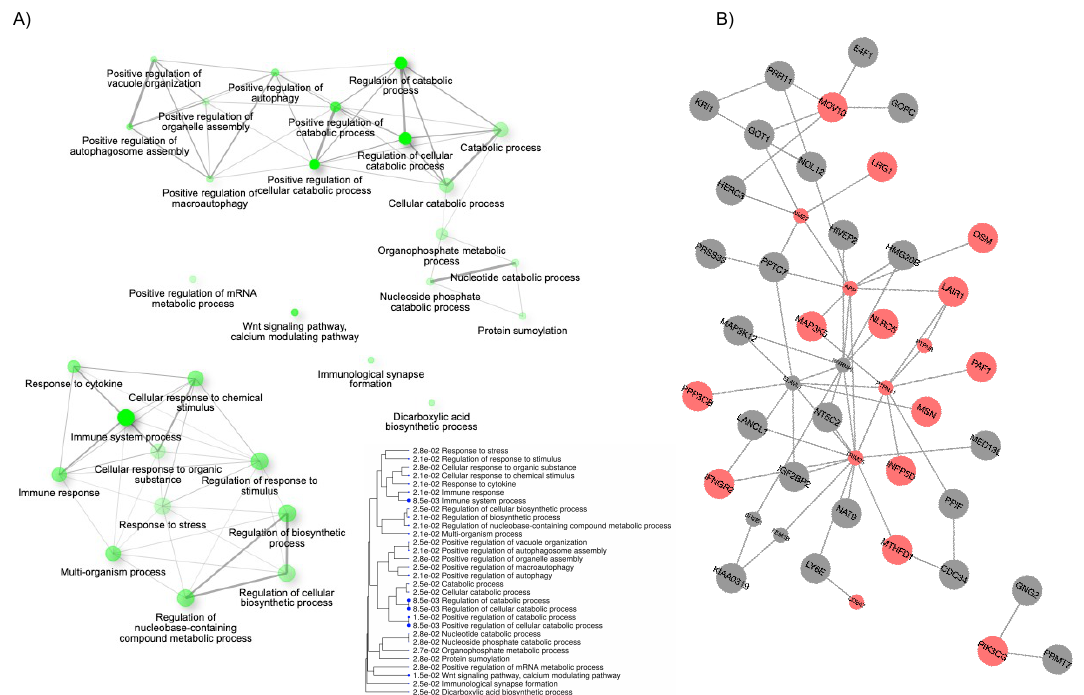
Figure 3. Gene set enrichment analyses reinforce the role of vitamin D3 on immune response modulation. ( A ) In the network map of gene ontology (GO) terms (top 30, ranked by enrichment FDR), connections are made if the terms (nodes) share 30% or more genes, with thicker edges represent more overlapped genes. Darker nodes reflect smaller p-values and size of the node reflects the number of genes. Gene composition of each term is available in Table S3. The term tree is a hierarchically ranked list with enrichment significance describing the hierarchical connection between GO terms. Larger blue dots indicate smaller p-values. The term tree and GO network were generated with ShinyGO v0.61. ( B ) Seeded network-based enrichment analysis was done using WebGestalt and identified 366 GO terms. The network at the top of the panel shows the seeded (i.e., input) gene names (large nodes), the top-ranking neighbor genes (small nodes), and the nodes involved in “immune system process” (GO:0002376) are highlighted in